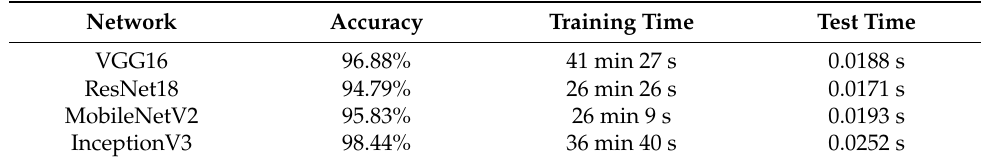
Table 7. Time requirements of four CNN networks.